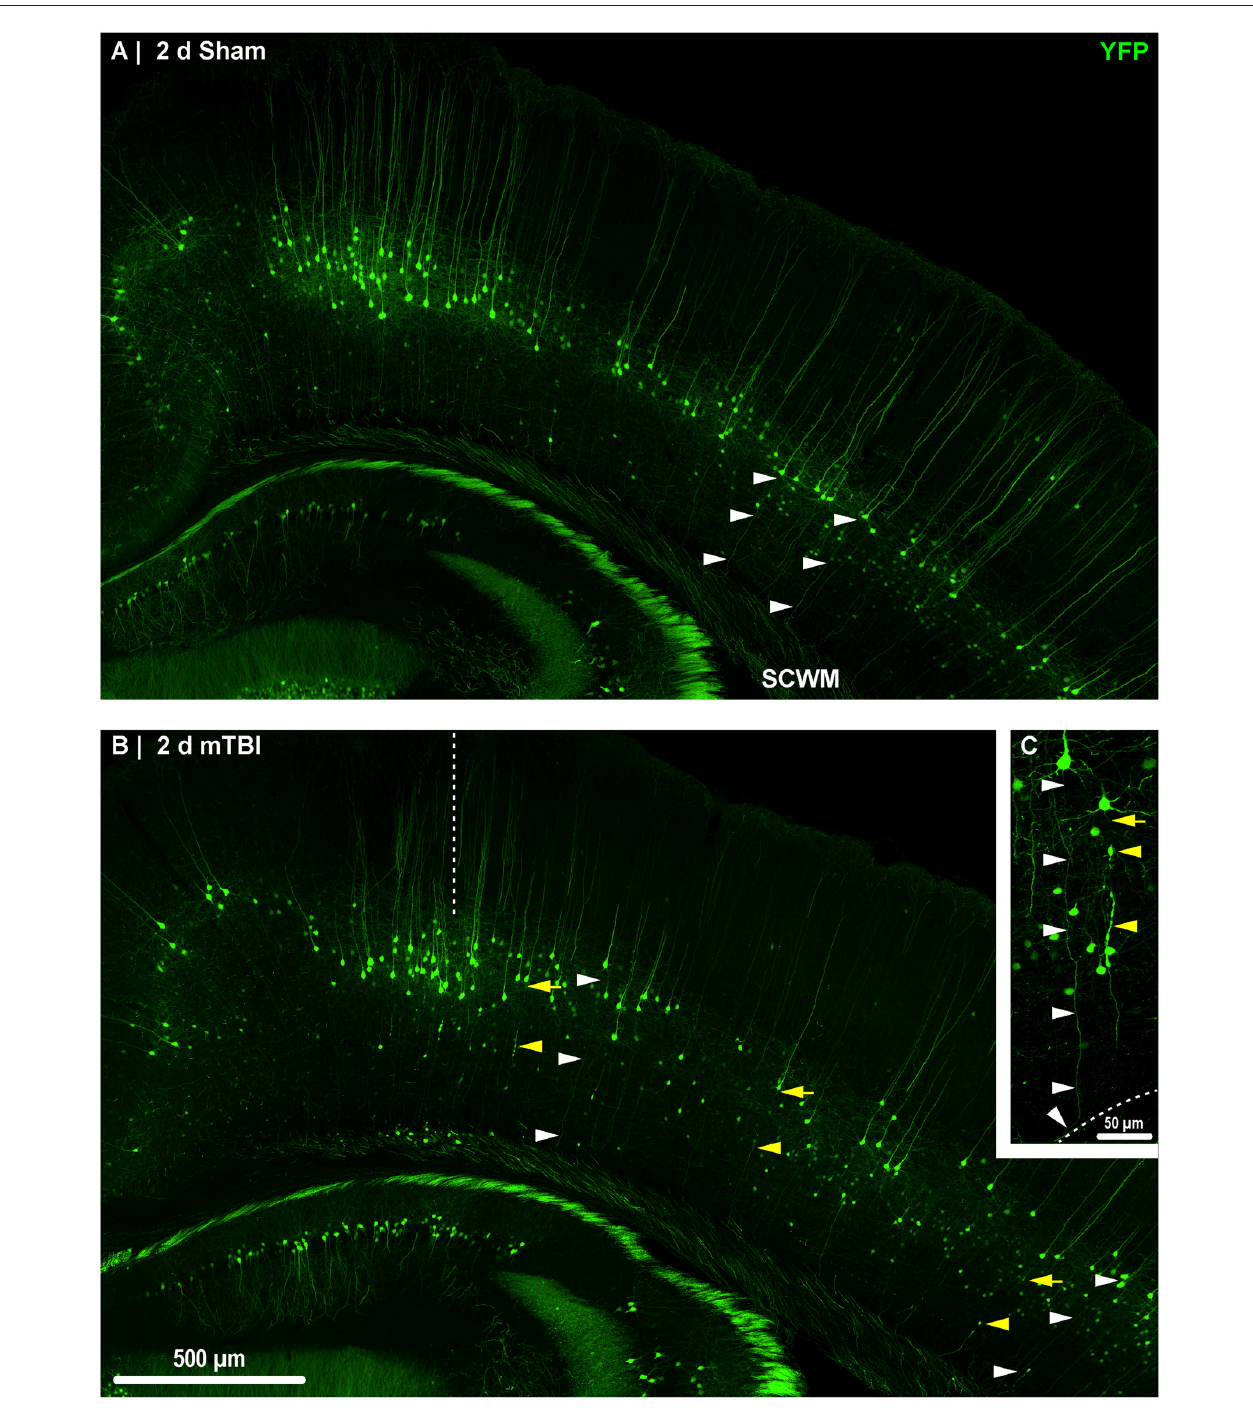
FIGURE 2 | Yellow fluorescent protein (YFP) expression in neocortical layer 5 pyramidal neurons. Representative images of sections from sham (A) and mTBI (B) brains shown in Figure 1 . Thy1 driven YFP expression results in restricted labeling of a discrete subset of layer 5 pyramidal neurons. (A–C) The selective YFP expression allows identification of individual axons that be traced from their soma of origin to the subcortical white matter (SCWM; white arrowheads). (B) Two days after mTBI, evidence of diffuse axonal injury (DAI) indicated by YFP+ axonal swellings is seen dispersed across the dorsolateral neocortex (yellow arrowheads). The craniectomy boundary is depicted by the vertical dashed line. No evidence of focal injury is observed under the craniectomy site. (C) A representative intact YFP+ pyramidal neuron juxtaposed by an injured axon. The intact axonal profile can be continuously traced from the soma of origin to where it enters the SCWM (dashed line), indicated by the acute change in